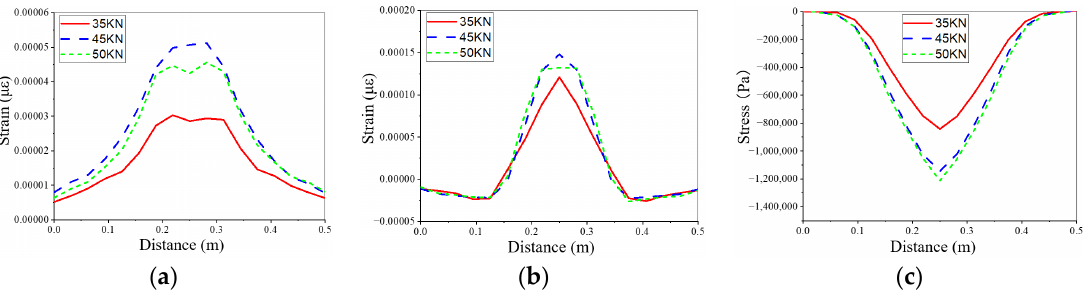
Figure 14. The dynamic responses under different axle load. ( a ) The longitudinal strain at the bottom of SFP. ( b ) The transverse strain at the bottom of SFP. ( c ) The vertical stress at the bottom of AC.